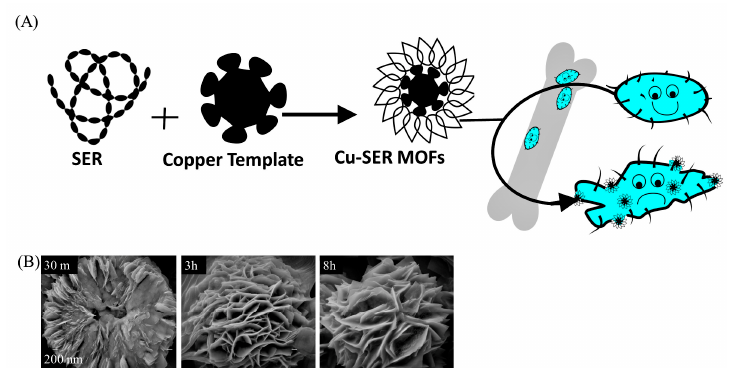
Figure 1. ( A ) Illustration of the self-assembly of Cu-SER MOFs and schematic of the investigation. ( B ) SEM images representing the time-dependent growth of MOFs (1 mg/mL SER, 1 mM CuSO 4 ): 30 min, 3 h, and 8 h of incubation